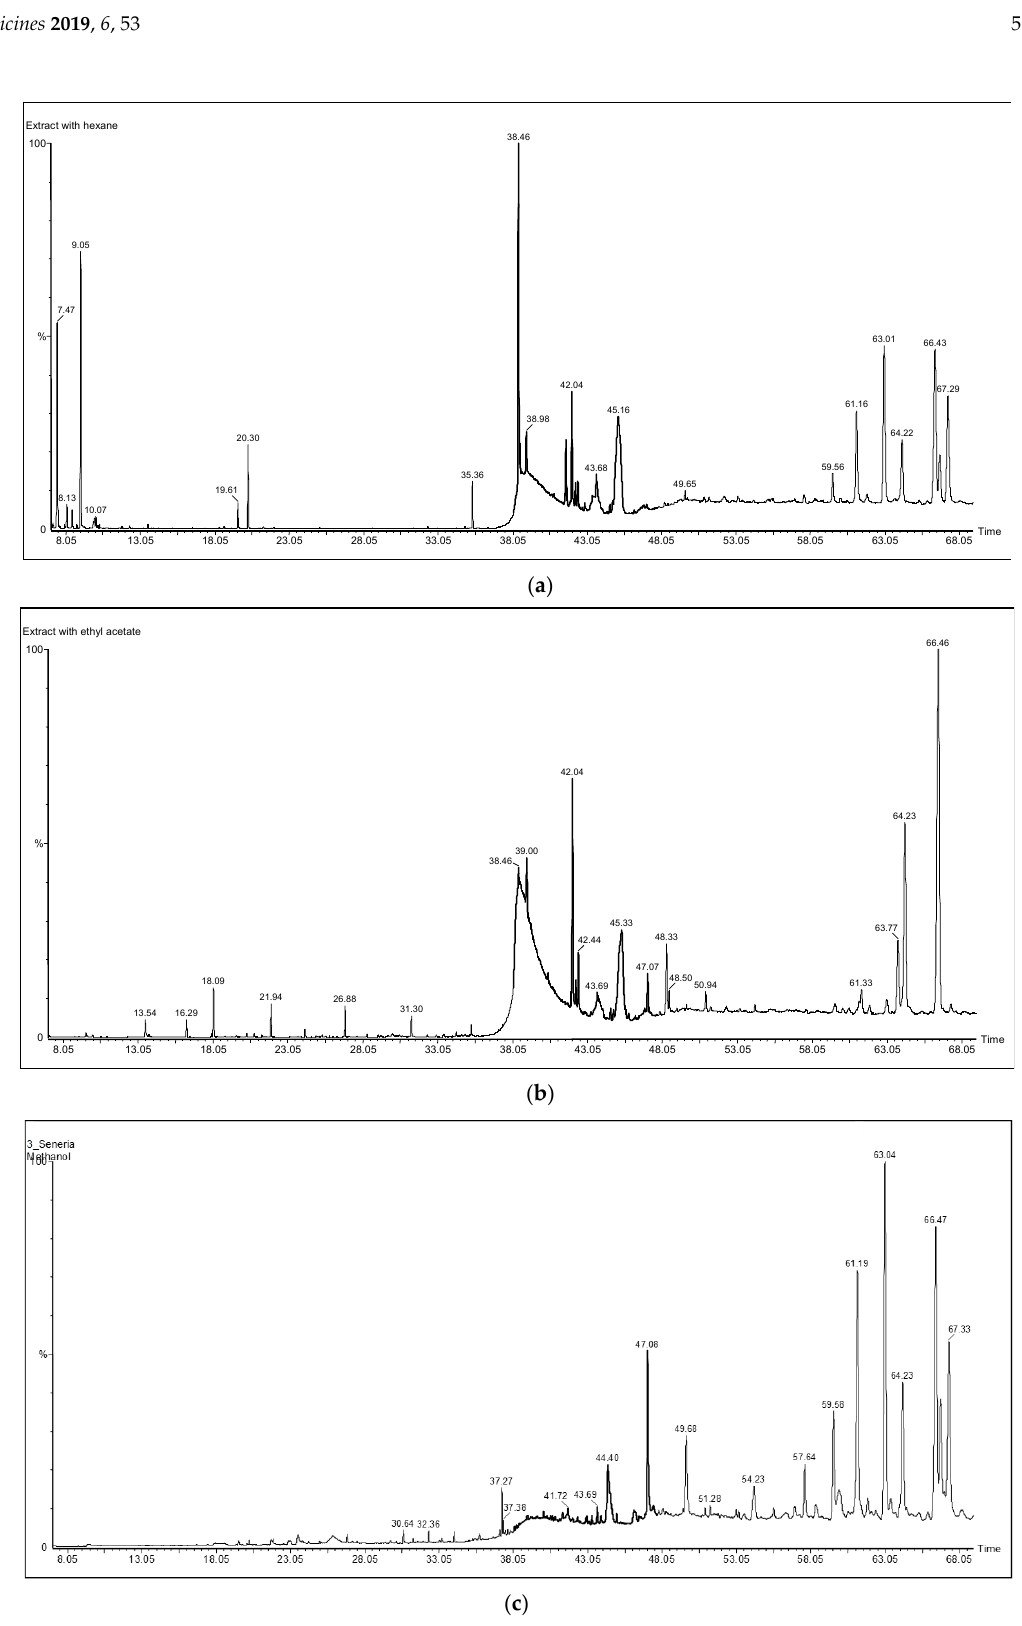
Figure 1. Typical GC-MS total ion chromatograms (TICs) of wild Scolymus maculatus extracts from n -hexane ( a ), ethyl acetate ( b ), and methanol ( c ).